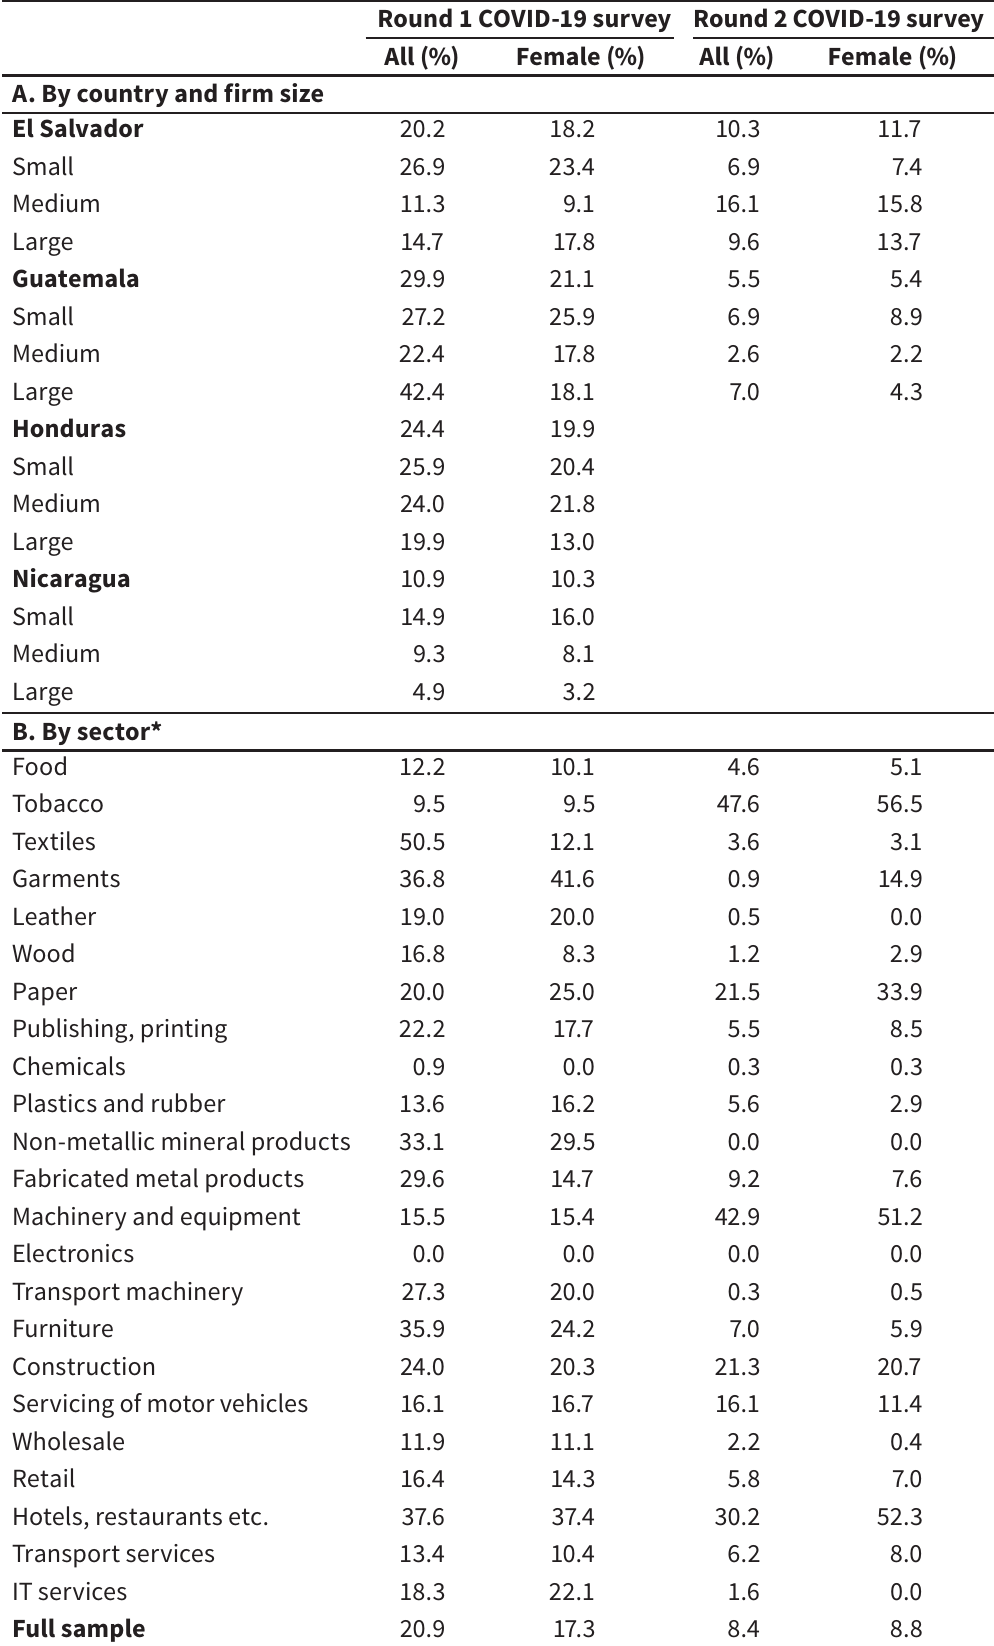
Workers furloughed as a % of full-time permanent employees* Round 1 COVID-19 survey Round 2 COVID-19 survey All